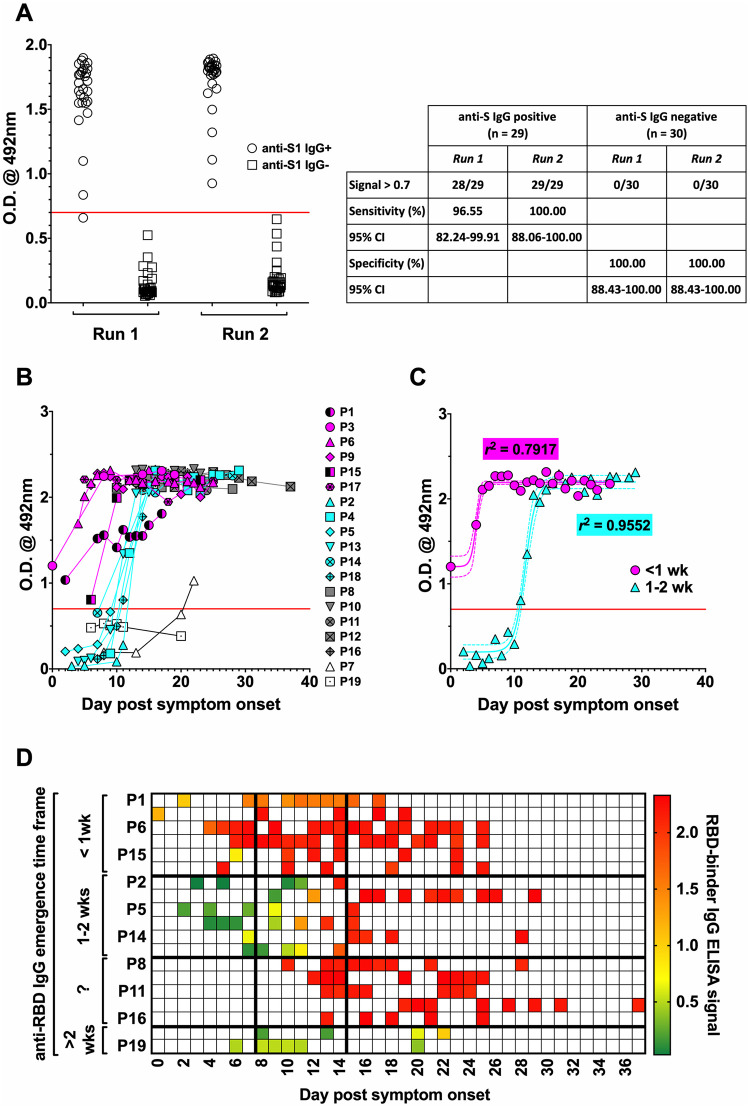
Temporal emergence of anti-RBD IgG antibodies.Serum samples collected from the cohort members over time were analysed for anti-RBD IgG by an ‘in-house’ ELISA. (A) The anti-RBD IgG ELISA was optimised by assaying sera previously shown to be either positive (n = 29) or negative (n = 30) for anti-S1 IgG by the EuroImmun assay; each serum was assayed in duplicate (means are depicted), and the optimisation was based on data from two separate runs. The calculated sensitivity and specificity of the anti-RBD IgG ELISA are described in the table. (B) Individual time-course data and (C) best-fit curves for the emergence of RBD-binding IgG occurring after < 7 days or between 7–14 days pso. In solid red line is the cut-off (0.7) for negative/positive seroreactivity. Patients #1 and #15 were considered outliers and were therefore excluded from best-fit curve analyses. In C–dashed lines indicate 95% CI ranges; r2 values describe tightness of fit. (D) Data from B presented as a heat-map. ‘?’ indicates undetermined seroconversion time frame.